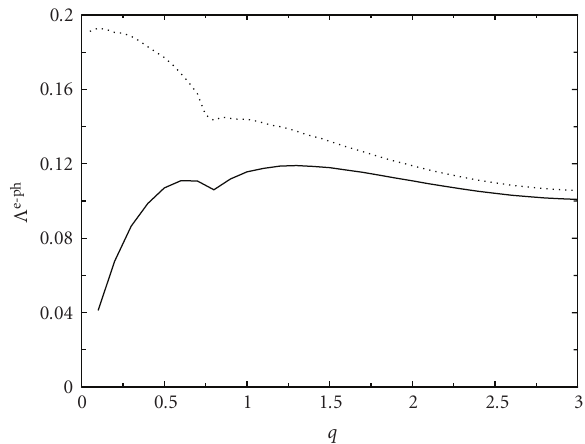
Figure 2: Static e ff ective e-ph vertex in units of the bare e-ph coupling g as a function of the transferred momentum (in units of the inverse lattice spacing 1 /a ) in the (1,0) direction. The vertex is calculated at leading order in 1 /N for a HH model with t = 0 . 5eV, t (cid:14) = − (1 / 6) t , ω 0 = 0 . 04 eV and doping x = 0 . 205. The dotted line is in the absence of long-range Coulomb forces ( V C = 0); the solid line is in the presence of long-range Coulomb forces with V C = 0 . 55 eV (adapted from